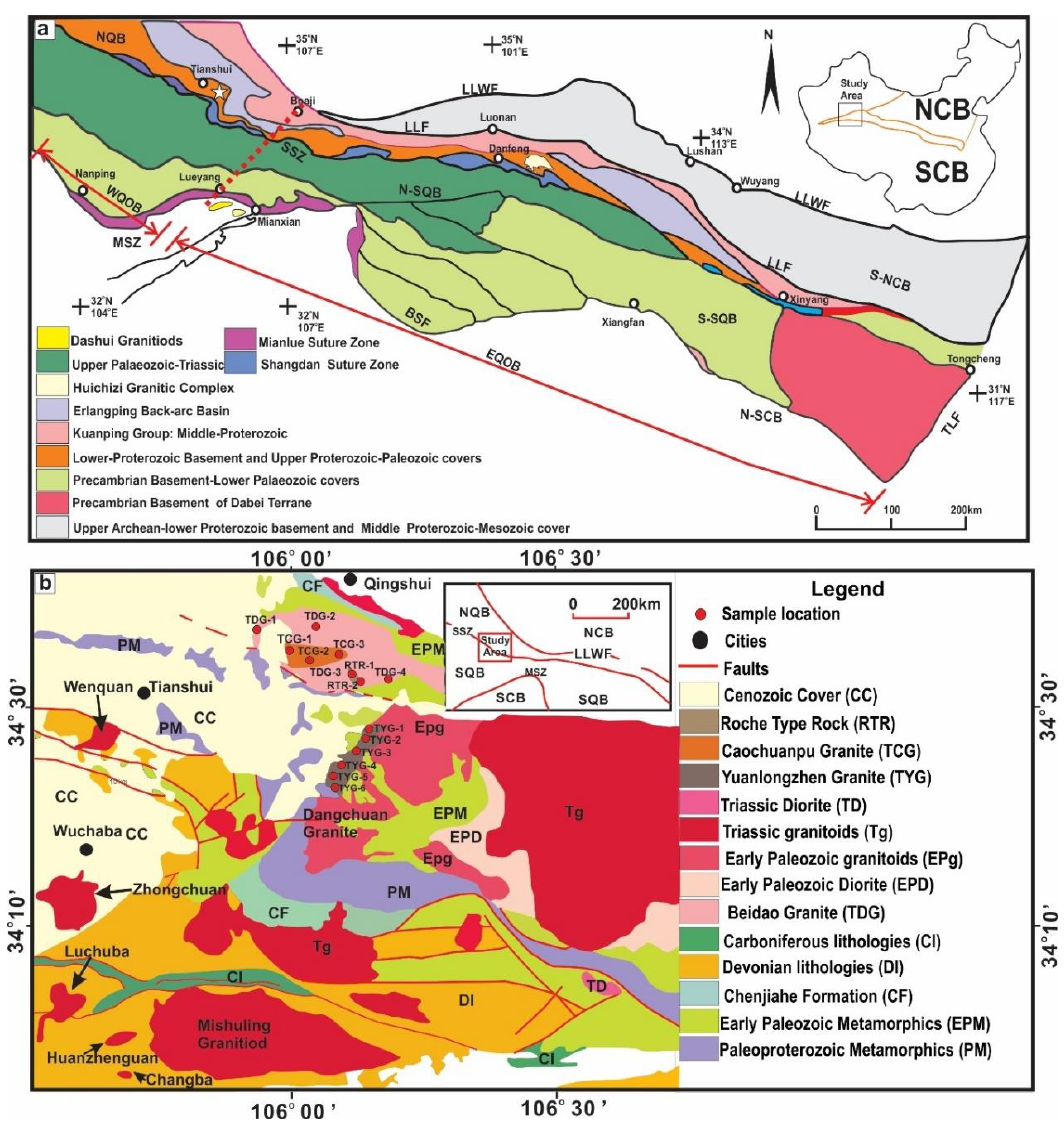
Figure 1. ( a ) Simplified geological and tectonic framework of the Qinling Orogenic Belt after [3]. Study area is located in the inset given at the top right corner where the square marks the study area. Granitoid rocks used in this study are located near Tianshui, marked by filled star. Red dashed line indicates the boundary between the Eastern and Western Qinling Orogenic Belt. ( b ) Geological map of the Tianshui area (after [23]). Small red circles indicate the sample locations that were used in this study. Abbreviations used on the map are: NCB = North China Block, SCB = South China Block, LLWF = Linbao-Lusahan-Wuyang fault, LLF = Luonan-Luanchuan fault, BSF = Bashan arc-shape thrust fault, TLF = the Tanlu fault, SSZ = Shangdan Suture Zone, MSZ = Mianlüe Suture Zone, NQB = North Qinling Belt, SQB = South Qinling